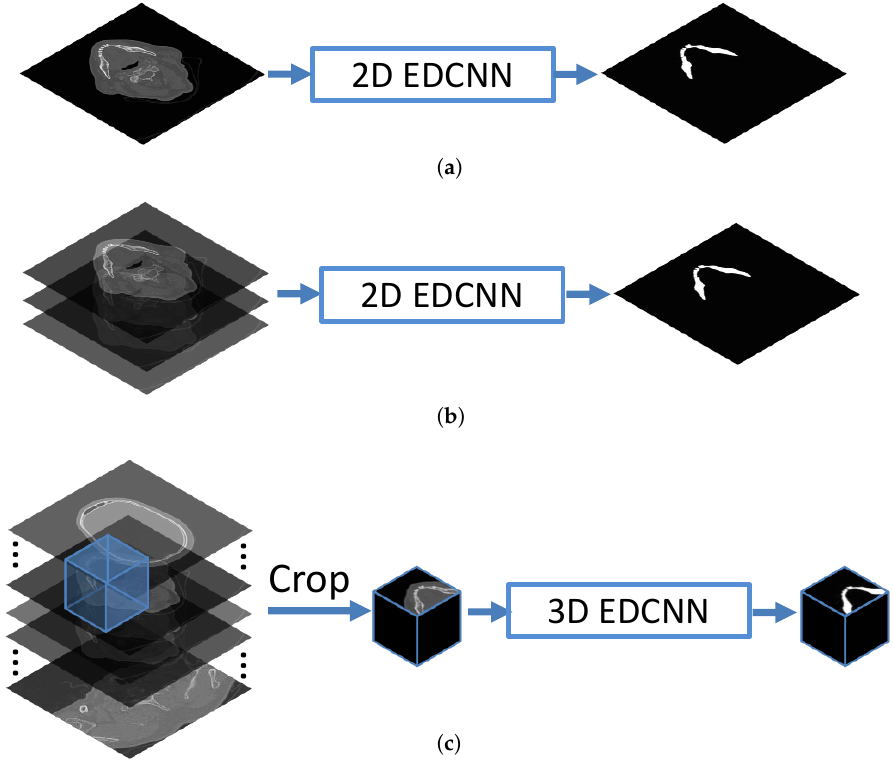
Figure 1. Illustration of three prevalent strategies for the feeding of input data to the classic encoder– decoder-based convolutional neural networks. ( a ) Use of 2D EDCNN network for 2D slice-based object segmentation. ( b ) Use of 2D EDCNN for the image segmentation based on several adjacent slices from the volumetric data. ( c ) Use of 3D EDCNN based on 3D patches cropped from the complete volumetric